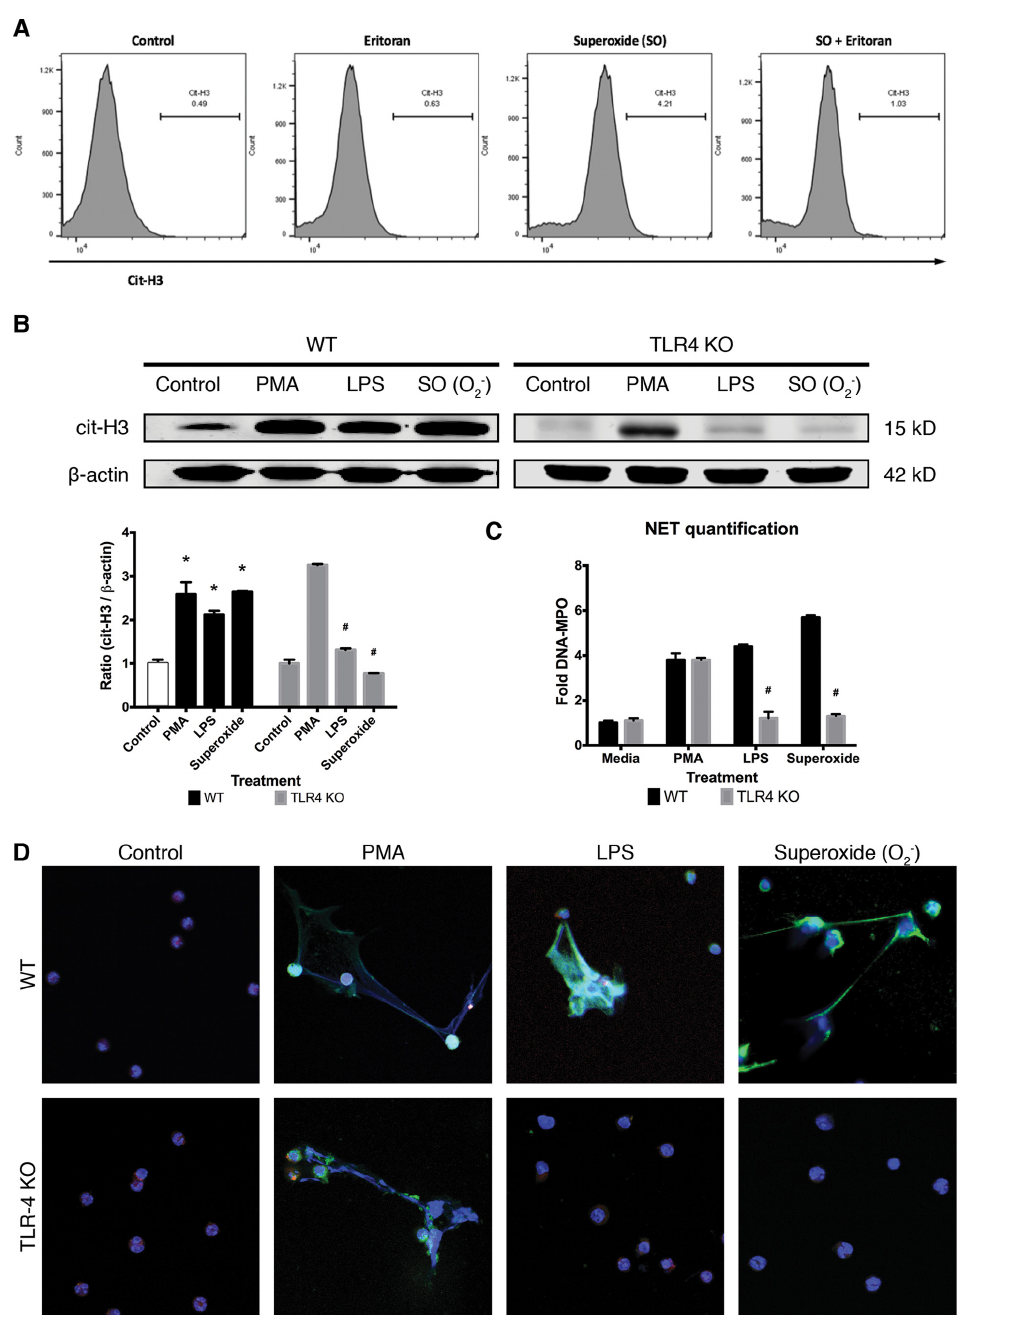
figure 3. TLR-4 mediates NET induction by extracellular superoxide. (A) Flow cytometry analysis of citrullinated Histone H3 in WT neutro- phils after treatment with media alone (control), eritoran TLR-4 antagonist (8 ng/mL), xanthine oxidase (10 mU/mL) and hypoxanthine (500 nM) to yield superoxide, or superoxide and eritoran, for 8 h. (B) Western blot of citrullinated Histone H3 in WT or TLR-4 KO neutrophils after treatment with media alone (negative control), PMA (100 nM), LPS (10 ug/mL), or xanthine oxidase (10 mU/mL) and hypoxan- thine (500 nM) to yield superoxide, for 1–8 h at 37°C. β -actin is shown as a loading control. Densitometric quantification chart shows mean ± SEM cit-H3 to β -actin, expressed as fold over control. (C) Assay of NET MPO-DNA complexes formed after treatment as above. Shown as mean fold over control. # p < .05 vs respective uninhibited treatment. (D) Neutrophils were fixed after treatment as above, immunolabeled with antibody to citrullinated Histone H3, detected with a conjugated fluorescent secondary antibody (green), then stained for DNA with Hoechst (blue). All figures represent at least 3 independent experiments for each